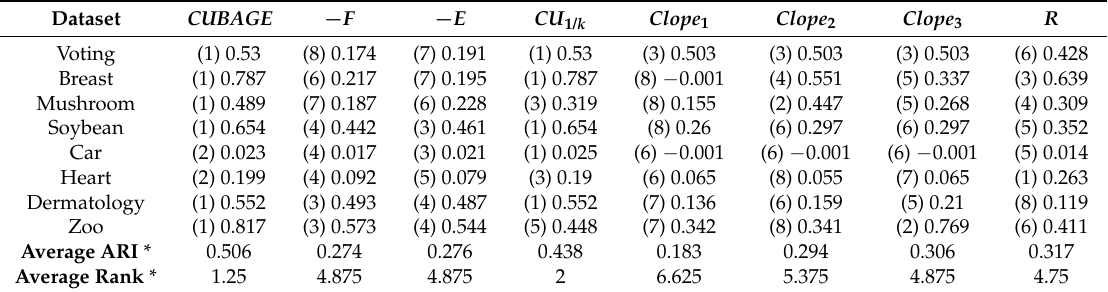
Table 9. Average ARI values of the chosen k -modes partitions over 100 runs ( k ranging from 2–10).